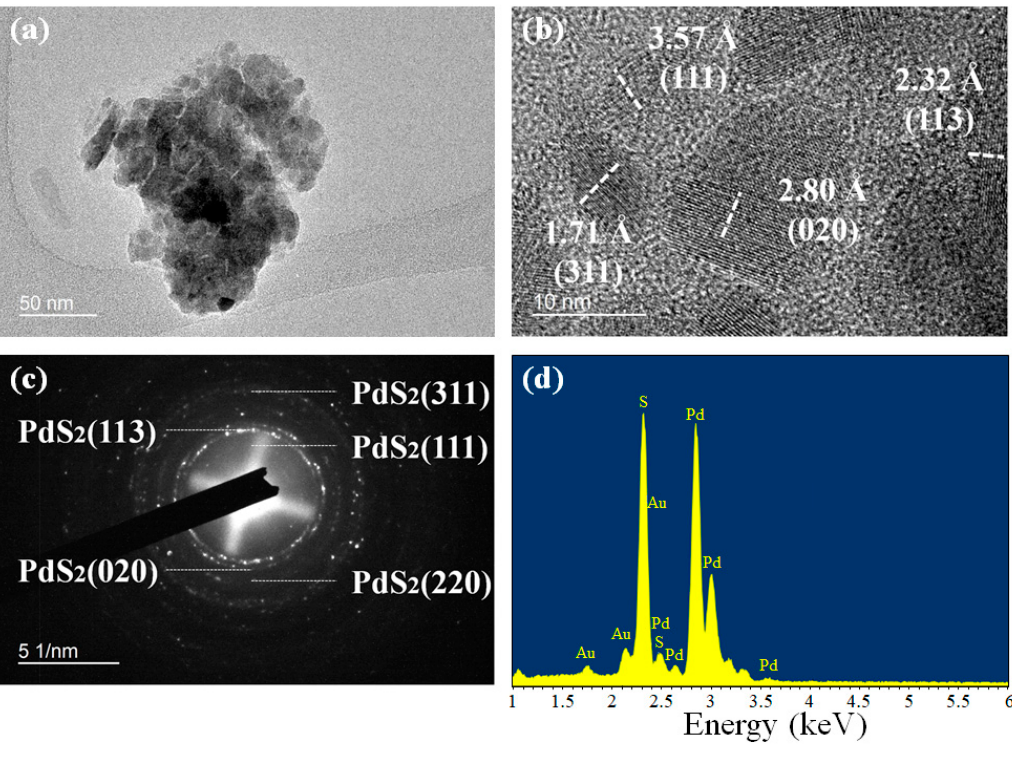
Figure 3. ( a ) An image of randomly selected flake with ( b ) high-resolution TEM image, and ( c ) corresponding SAED pattern by FETEM measurement. ( d ) EDS spectrum by SEM measurement .